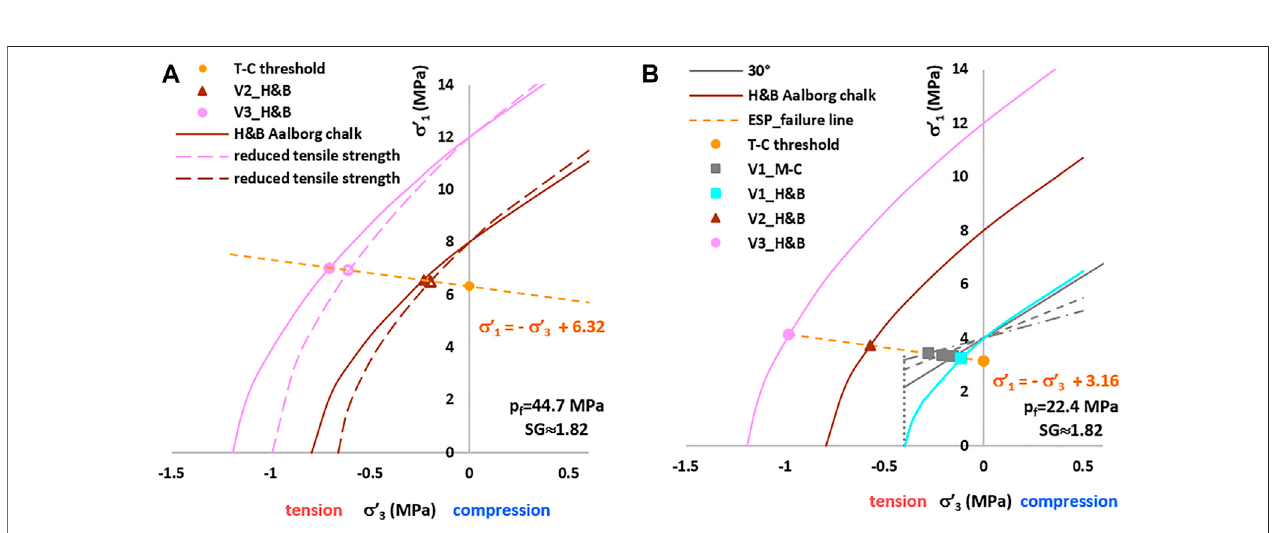
FIGURE8|(A) Comparisonofthestrengthenvelopesofthechalkwith σ c =8 – 12 MPa; m t =10and σ c / σ t ≈ 10; σ c / σ t ≈ 12and m t =12(reducedtensilestrength). (B) Cases V1, V2, and V3 at a depth z = 1,250 m: σ h = 23.93 MPa, p f = 22.35 MPa.